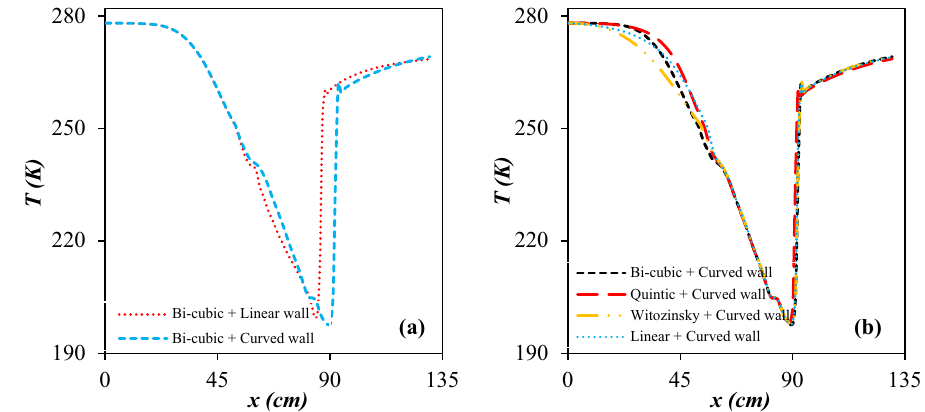
Figure 6. The influence of diffuser line-type ( a ) and convergent section line-type ( b ) on the temperature profile at the center-line of considered